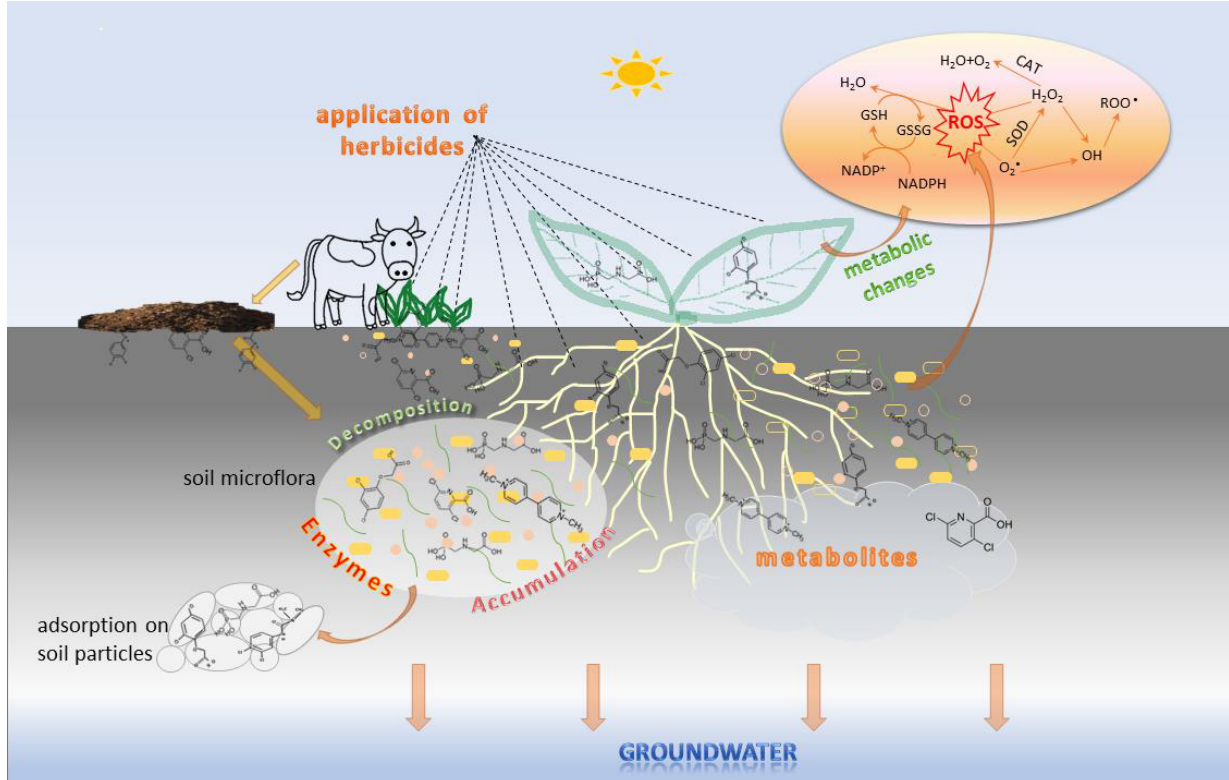
Figure 2. Factors influencing herbicide fate/behavior in soil.